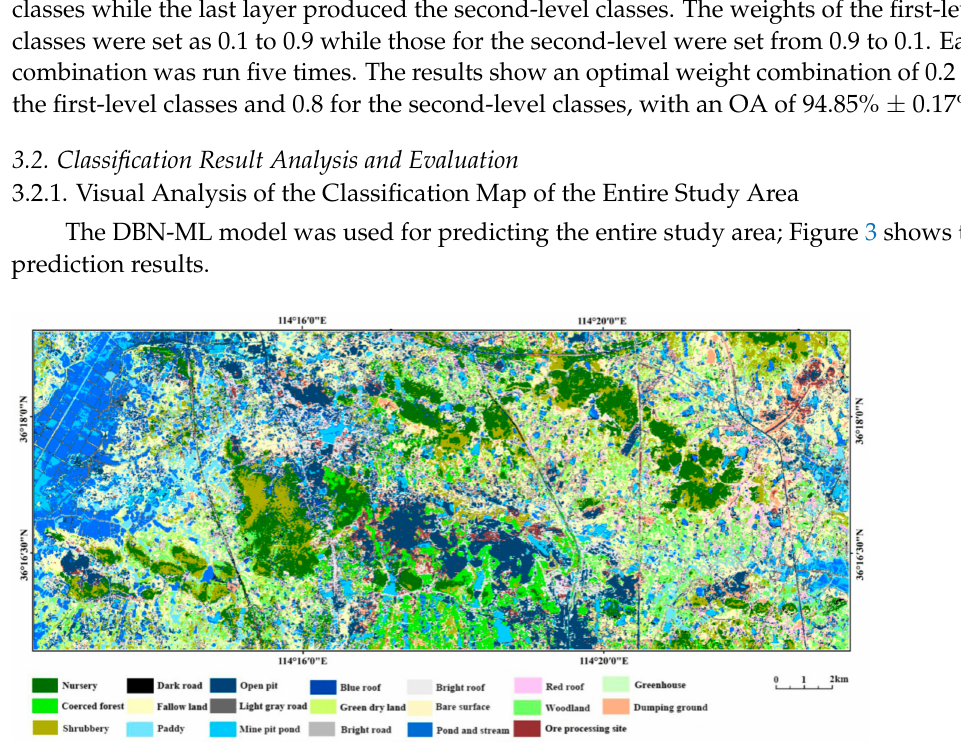
Figure 3. Classification results based on the DBN-ML for the entire study